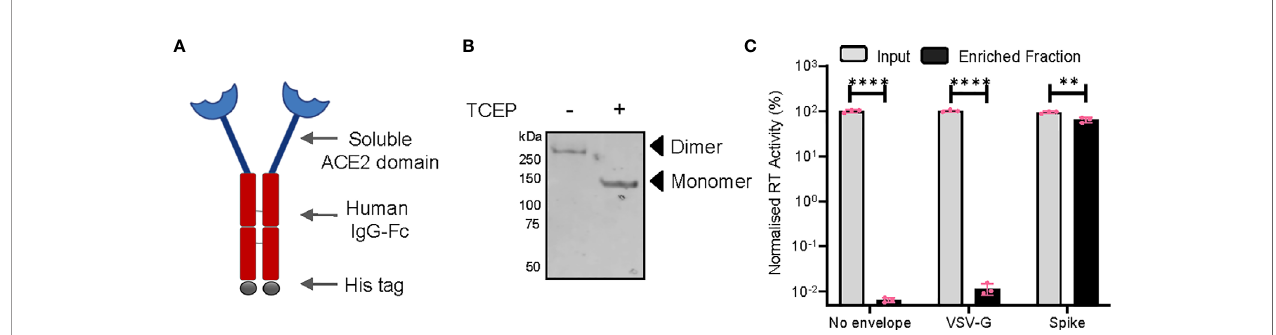
FIGURE 3 | Characterization of the ACE2-IgFc microbody. (A) Schematic of the ACE2-IgFc neutralizing microbody. (B) Effect of a reducing agent (TCEP) on the migration of ACE2-IgFc on the gel. Anti-His antibody indicating monomeric vs dimeric states of the protein visualized by western blotting from the cell culture supernatant. (C) Protein G-bound ACE2-IgFC and the enrichment of virus particles. The RT activity of the input VSV-G or Spike particles was normalized to the non-enveloped particles, set to 100%. n=3 ± SD. **p < 0.01; ****p